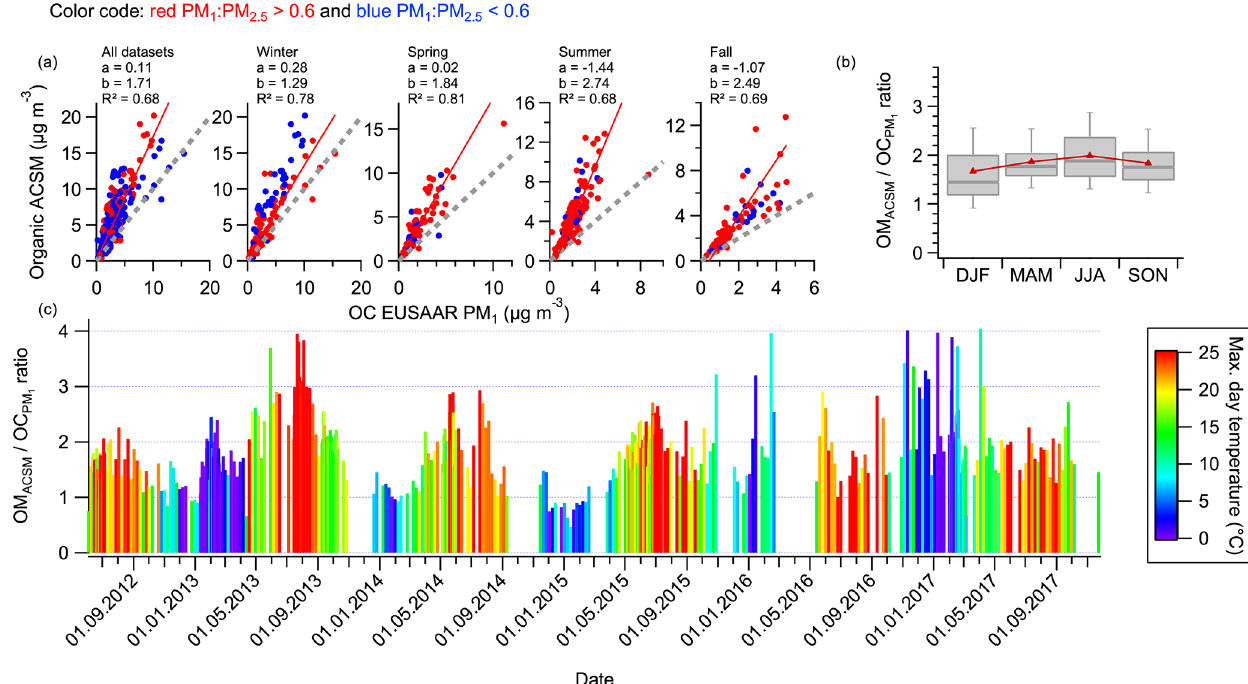
Figure 6. (a) Correlation between ACSM organic mass concentrations and offline OC PM 1 ; (b) seasonal variability in the estimated OM ACSM :OC PM ratio; (c) the entire time series colored by maximum daily 1